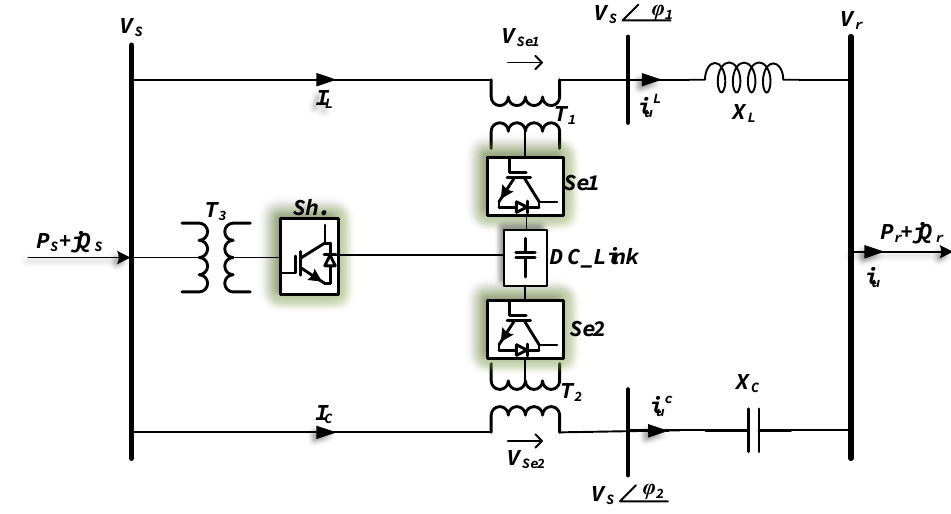
Figure 1. The actual model of unified interphase power controller (UIPC) equipment.